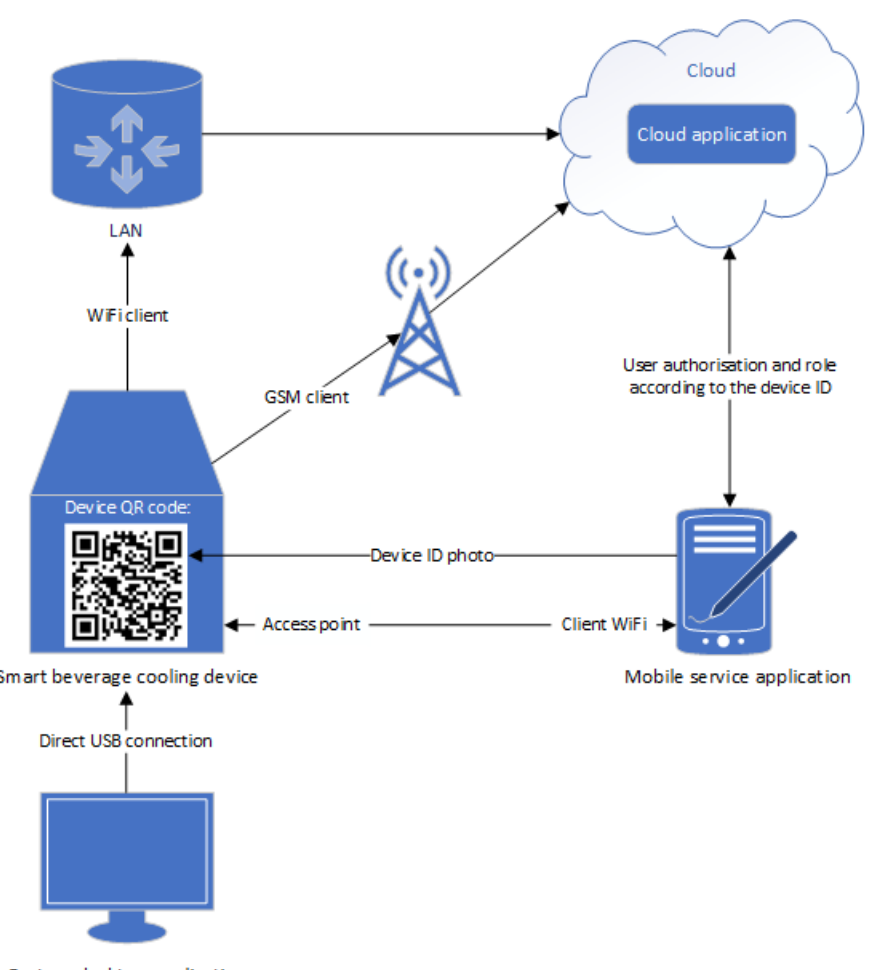
Figure 11. The security concept of the